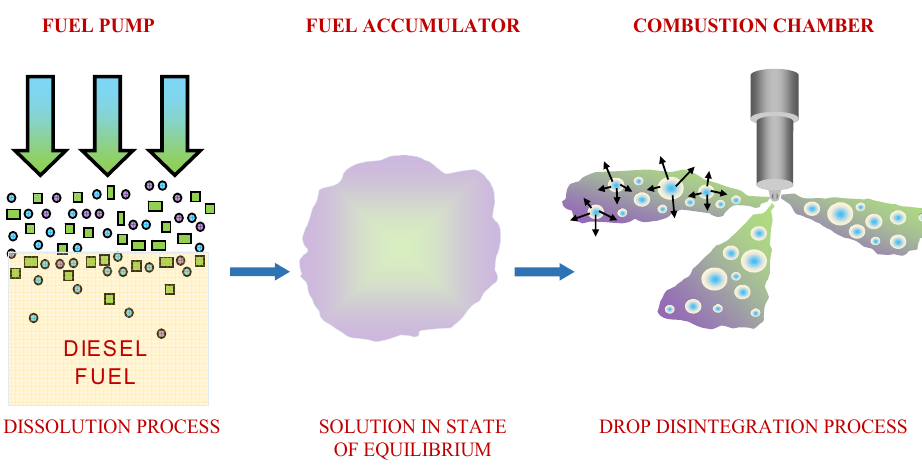
Figure 1. Concept of assisted atomization based on the desorption effect.